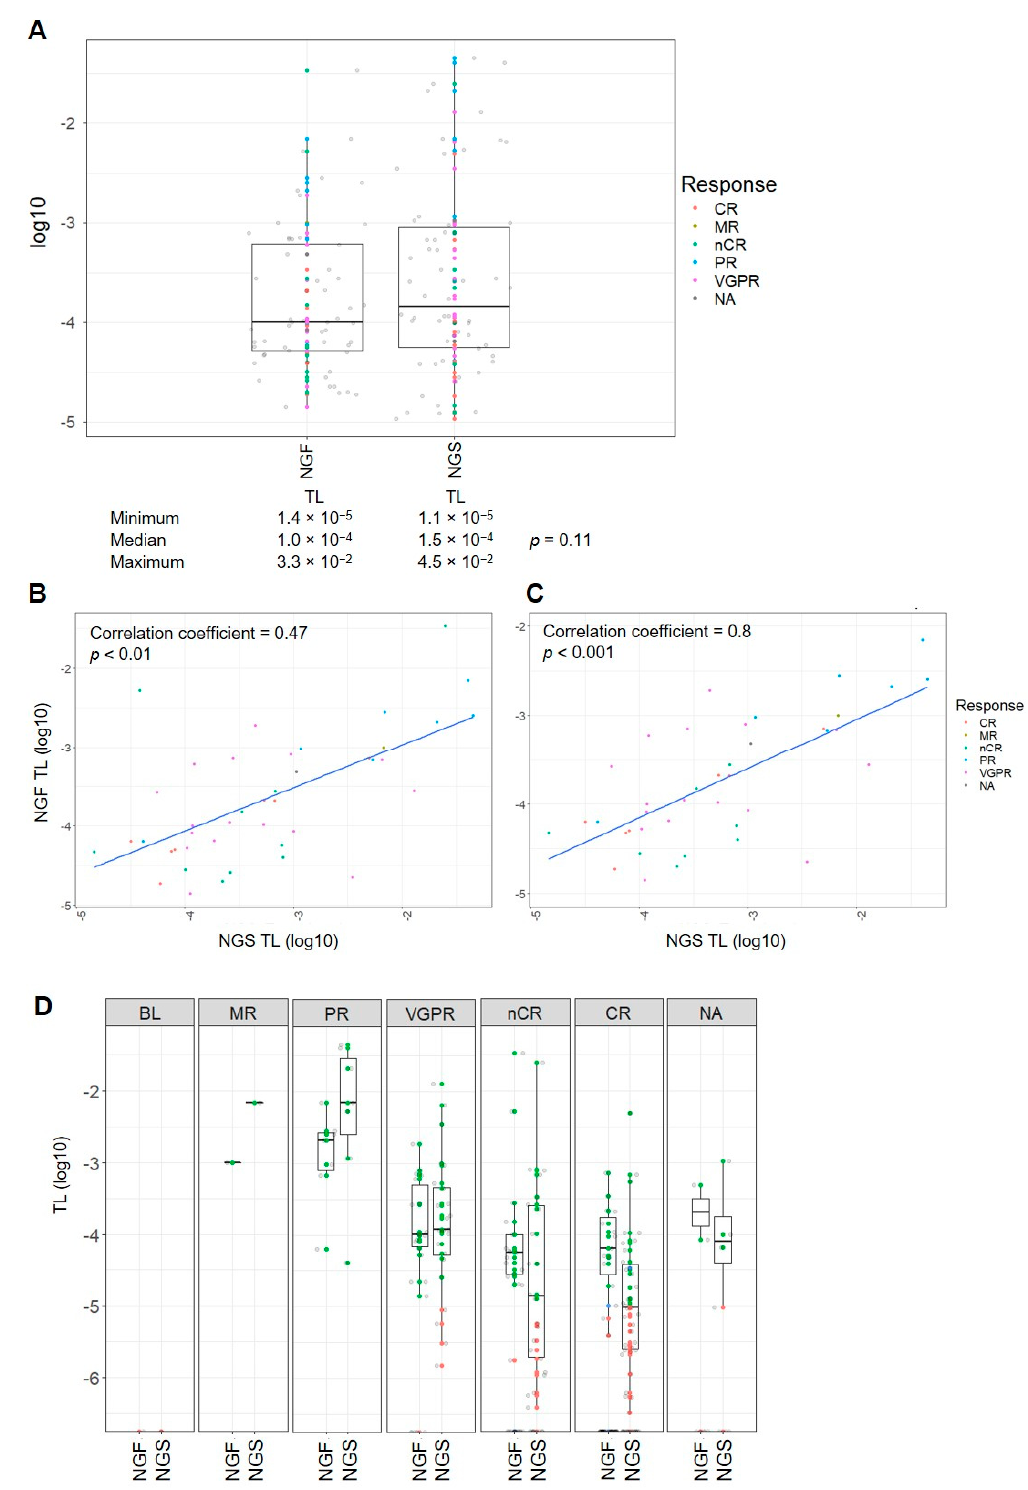
Figure 5. Tumor load in MRD-positive cases. The figure shows the tumor loads (TLs) of NGS/NGF MRD-positive cases at an MRD cut-off of 1 × 10 − 5 . The results are presented ( A ) cumulatively for all these cases and ( D ) according to serological response; all comparison p -values > 0.05; green, MRD-positive; red, MRD-negative; blue, MRD-nonassessable due to a missed LOD. The correlation between the TLs of the MRD-positive pairs assessed by NGS and MFC is shown for ( B ) all pairs and ( C ) after removal of two extreme outliers. BL, baseline; CR, complete remission; MR, minimal response; NA, not available; nCR, near complete remission; PR, partial remission; TL, tumor load; VGPR, very good partial remission.